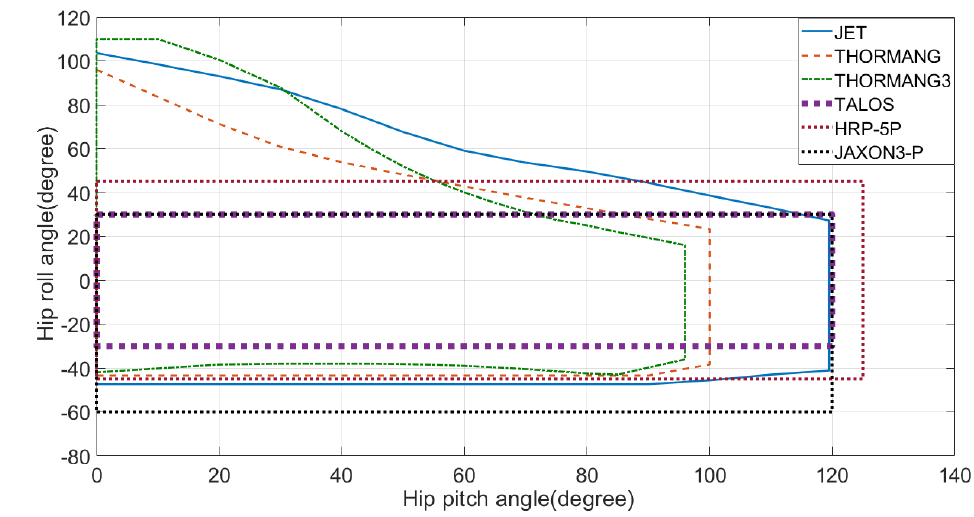
Figure 6. ROM comparison for JET, THORMANG, THORMANG3, TALOS, HRP-5P, and JAXON3-P hip